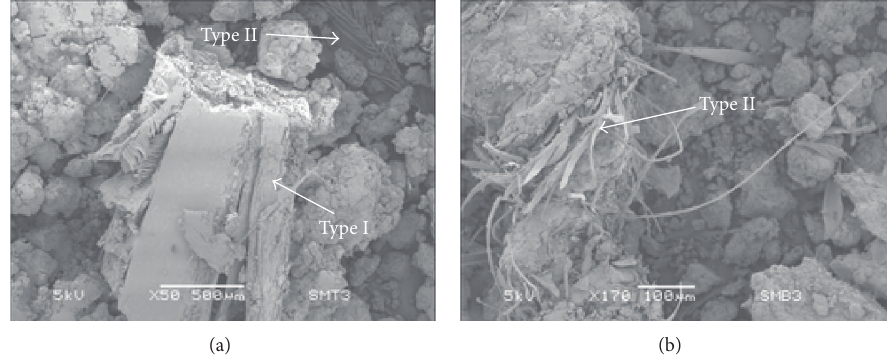
Figure 7: SEM micrographs of modified soil with total fibers 50x (a) and barbs 170x (b).